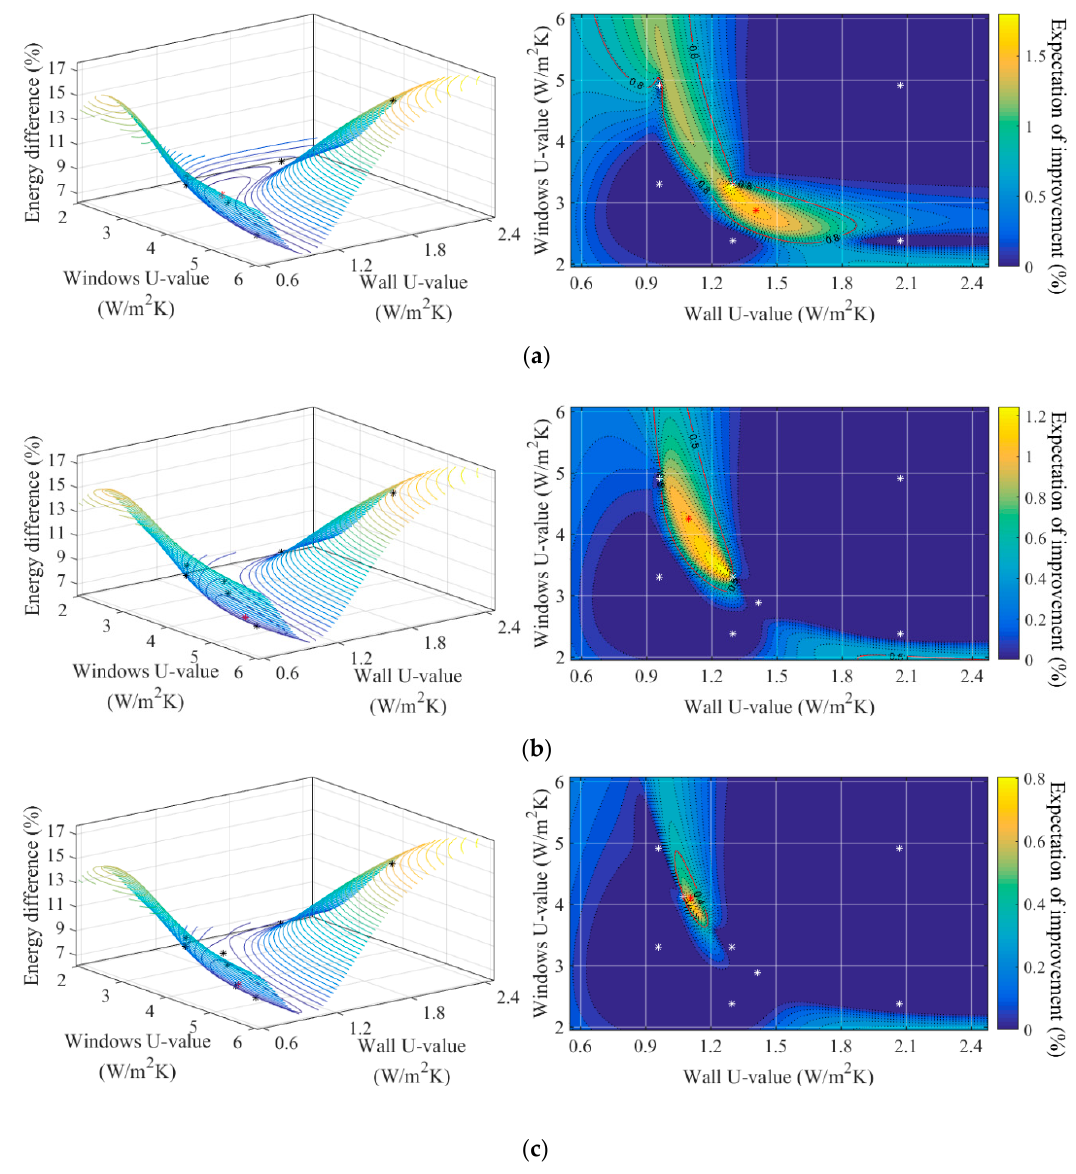
Figure 7. Two parameters calibration result after ( a ) the first iteration, ( b ) the second iterations and ( c ) the third iterations.